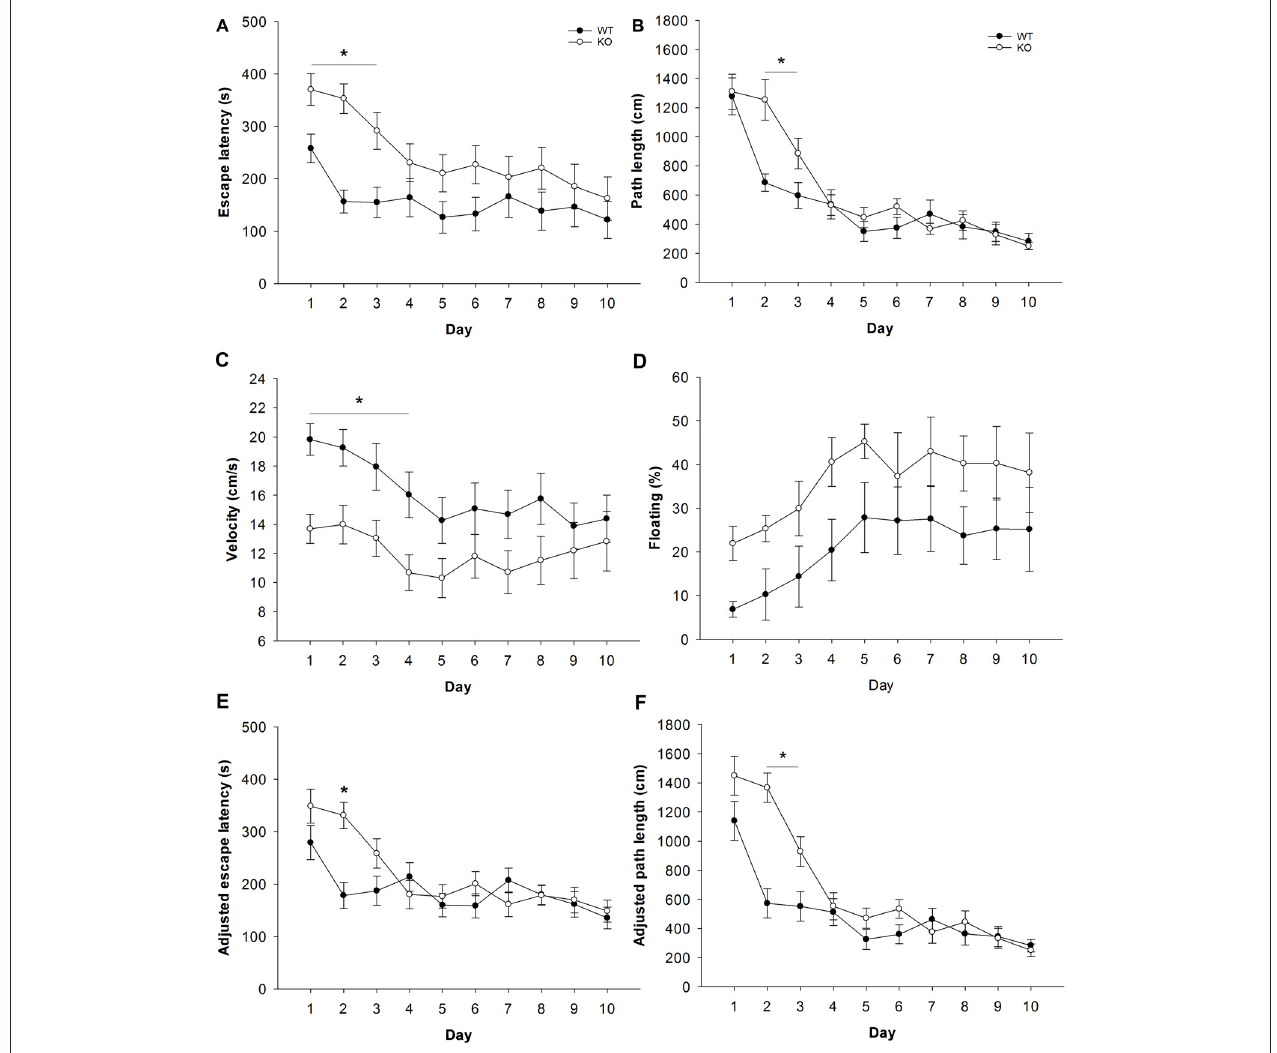
FIGURE 8 | Fuca1-deficient mice display impaired spatial learning during water maze acquisition. (A–F) Morris water acquisition in 3-month-old Fuca1-deficient mice (Fuca1 -/-, white circles) and age-matched WT littermates (black circles). Fuca1-deficient mice were significantly slower to locate the hidden platform during the first 3 days of acquisition ( A , escape latency). Furthermore, they traveled more distance than WT mice before reaching the platform during days 2 and 3 ( B , path length). However, these mice also showed reduced swimming velocity during days 1–4 (C) as well as a tendency for increased immobility (D) . Adjusted escape latencies (E) and path lengths (F) showed residual defects in spatial learning of Fuca1-deficient mice after taking into account variability in swimming velocity (during days 2 and 2–3 respectively). All data are presented as mean ± SEM (both genotypes n = 15). Asterisk indicates significance of difference.